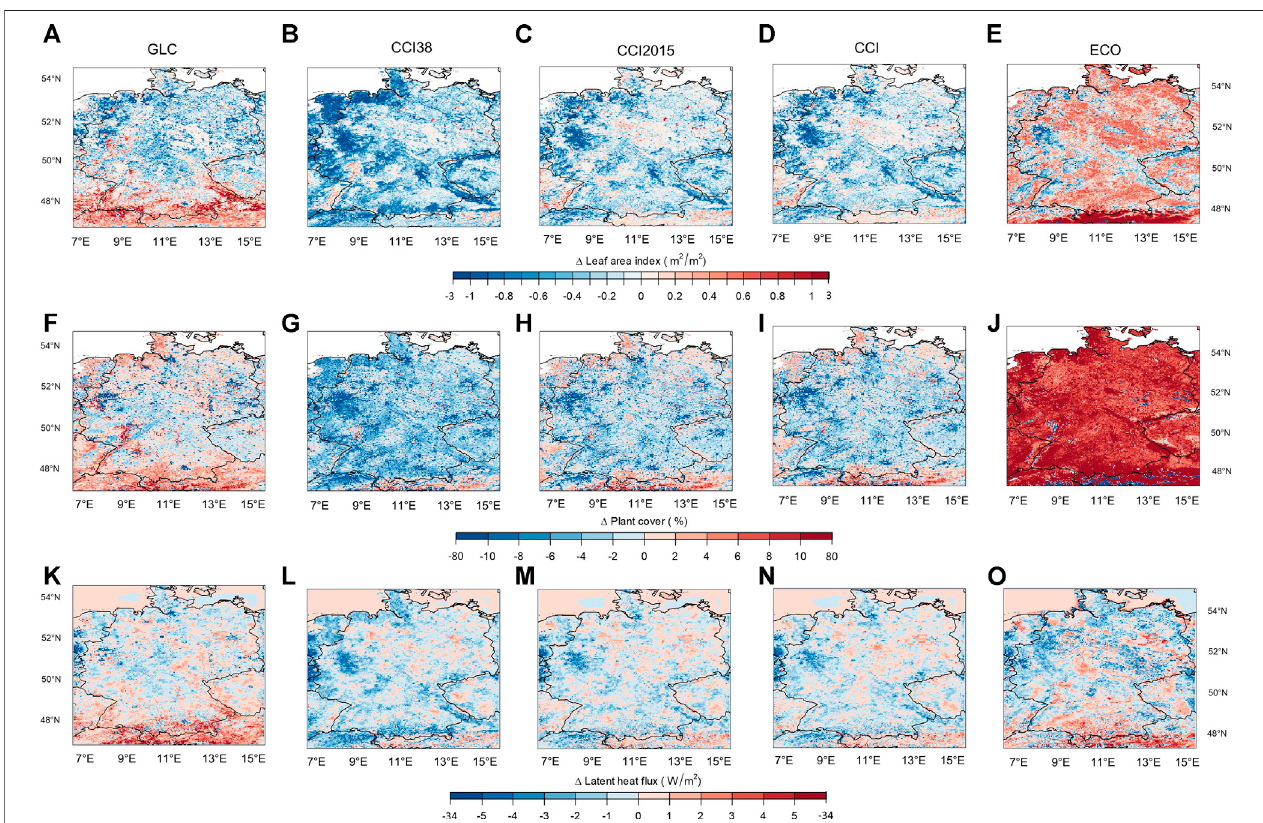
FIGURE 7 | Distribution of latent heat fl ux (A – E) , LAI (F – J) , and plant cover (K – O) differences between the experimental simulation based on the GLC land cover map( fi rstcolumn),theCCI38landcovermap(secondcolumn),theCCI2015landcovermap(thirdcolumn),theCCIlandcovermap(fourthcolumn),theECOlandcover